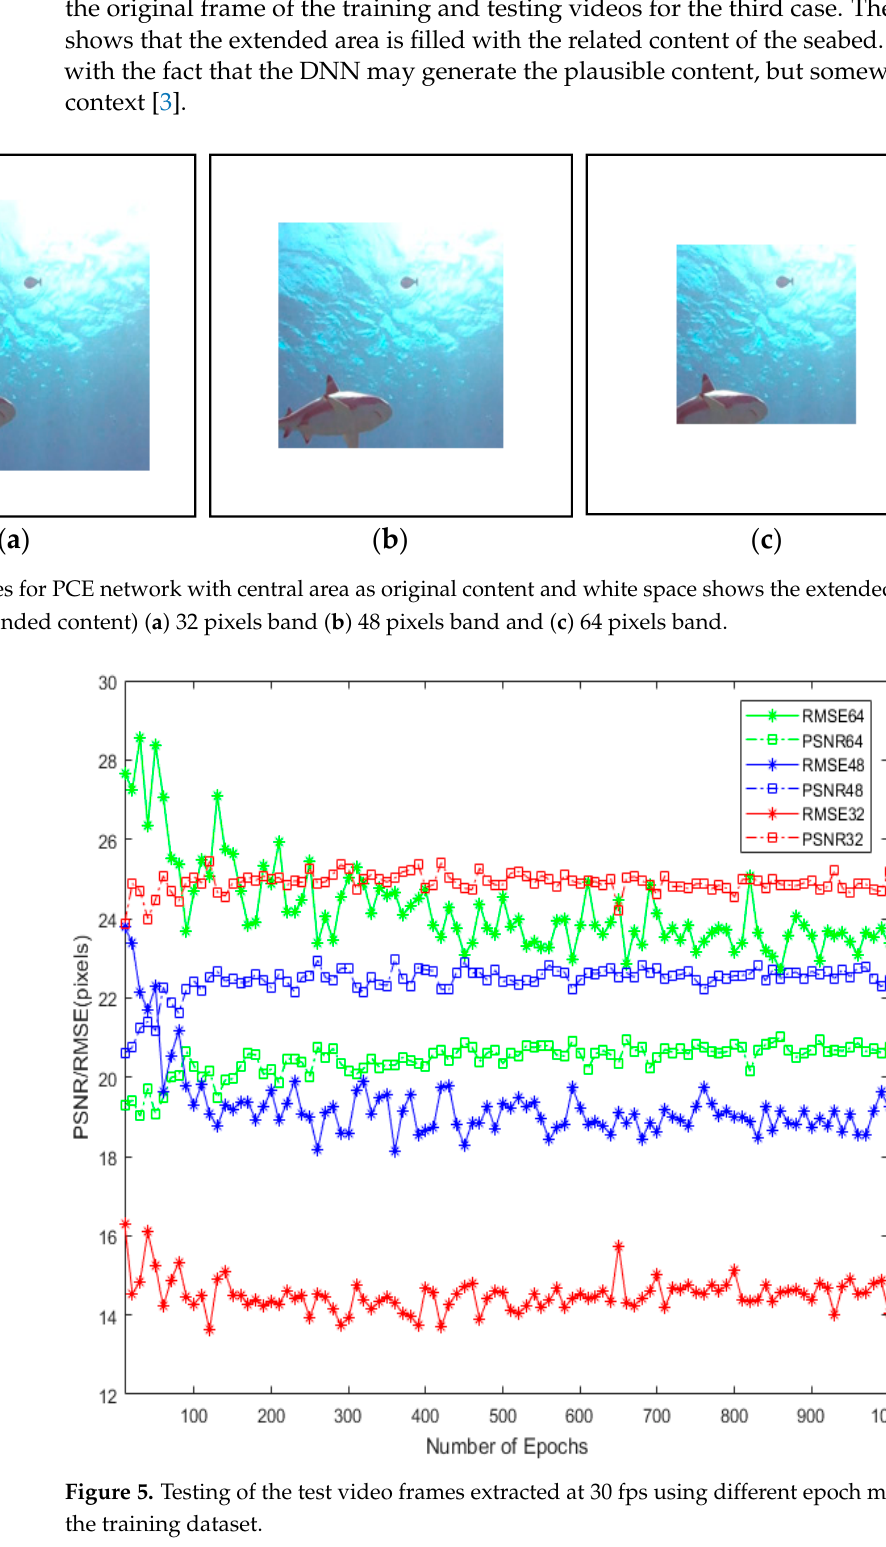
( f ) Figure 6. The extension of the video frame using PCE for training videos (1st row) and testing video (2nd row), ( a , d ) Input video frame ( b , e ) Output video frame, and ( c , f ) Target video frame. In another experiment, we used two different categories of datasets, i.e., Ocean and forest datasets for PCE with only 64 pixels band (extended area). We used four videos of Ocean dataset (94 K frames extracted at 2 fps) for training and the PCE is trained for 753 epochs (1 epoch = 4700 steps). We then tested the trained PCE model on the two videos of Ocean dataset (frames extracted at 2 fps). We repeated the training of PCE with Forest dataset with seven videos (123 K frames extracted at 2 fps) and the PCE is trained for 1000 epochs (1 epoch = 6155 steps). We tested the trained PCE model on the two videos of Forest dataset (frames extracted at 2 fps). The testing results for PCE for the Ocean and forest data sets are shown in Figure 7. The testing result of the Ocean dataset shows that the